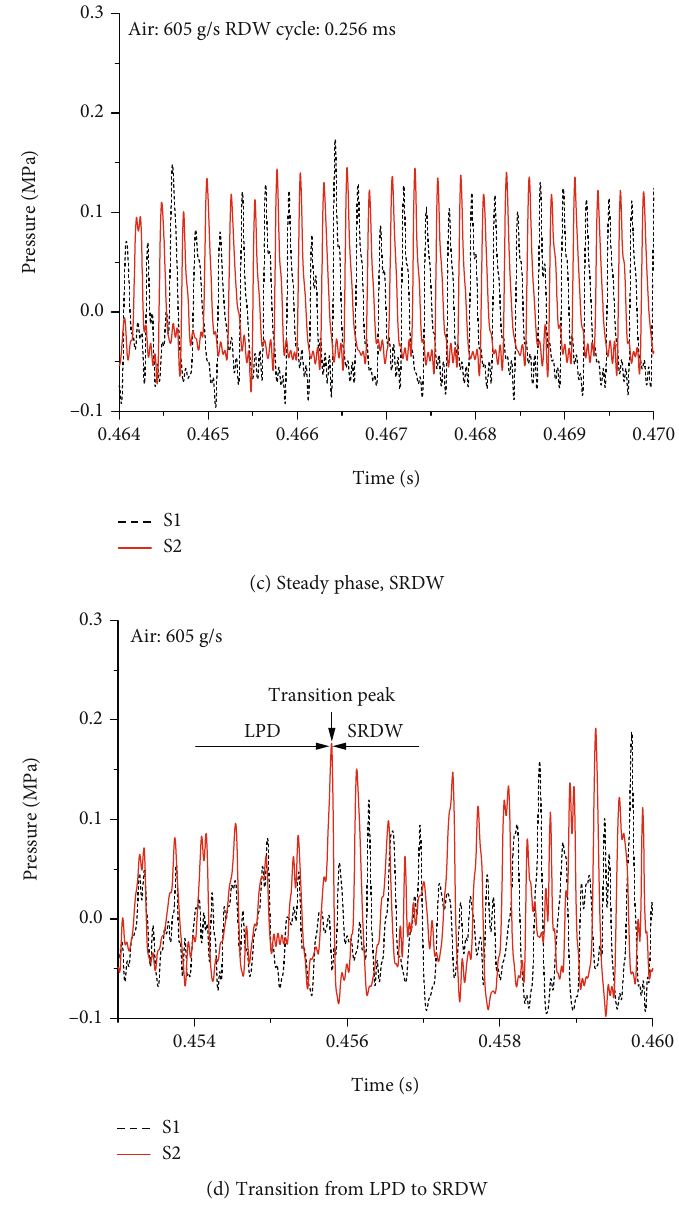
Figure 7: Pressure traces obtained by S1 and S2 for the air mass fl ow rate